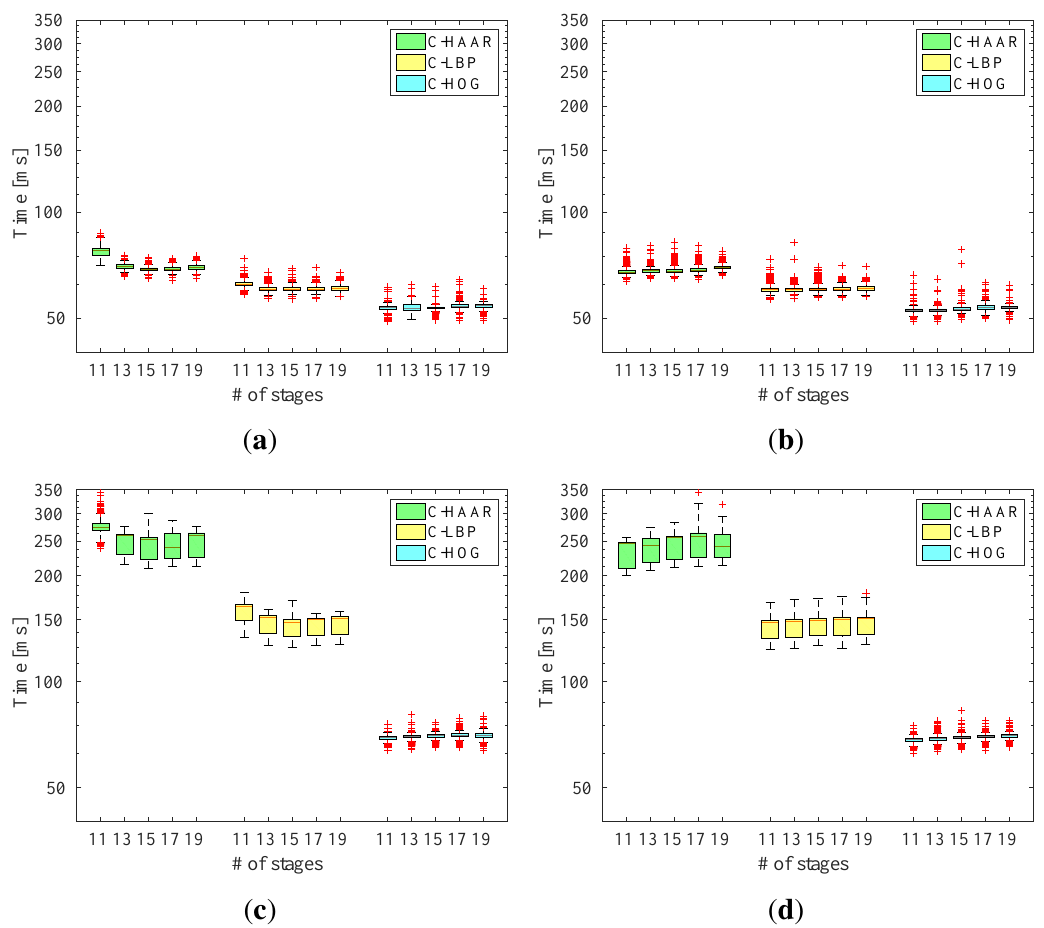
Figure 20. Analysis of time required to process one frame of ( a , b ) indoor and ( c , d ) outdoor videos. In ( a , c ), the classifiers are tested with their default thresholds, whereas in ( b , d ), the thresholds yielding the maximum F-score are used.